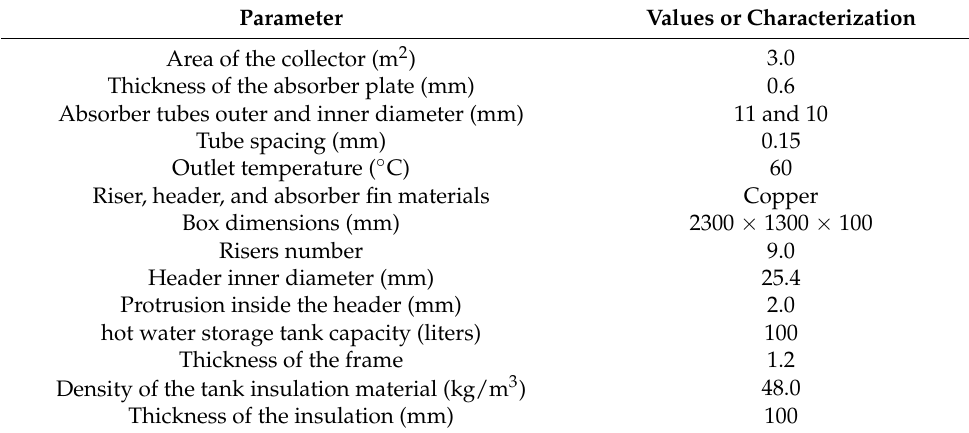
Table 6. Specifications of the solar flat plate collector (FPC).